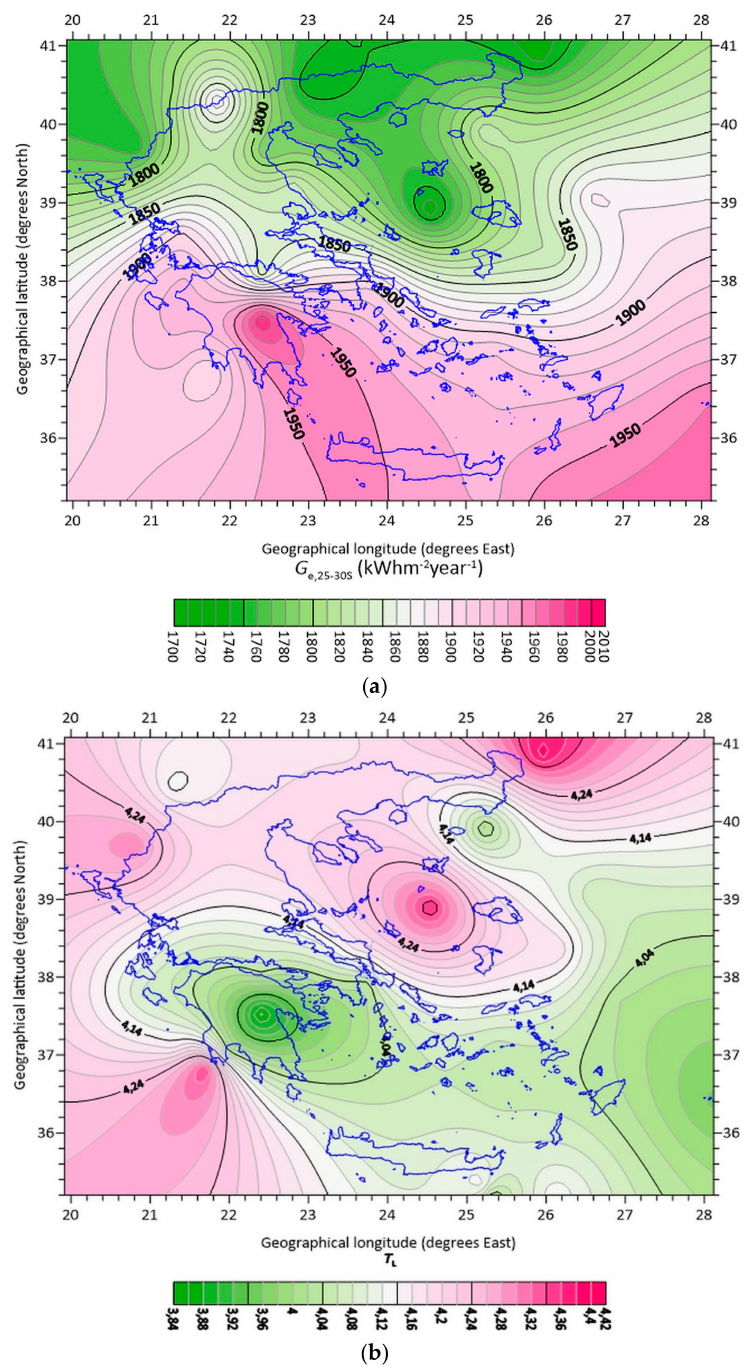
Figure 11. Distribution of the annual mean G e ,25S-30S sum ( a ) and the annual mean T L ( b ) (which was adopted from Kambezidis and Psiloglou [66]) values over Greece. The PV ctts thresholds of 1900, 1850, and 1800 kWhm − 2 · year − 1 can be identified in ( a